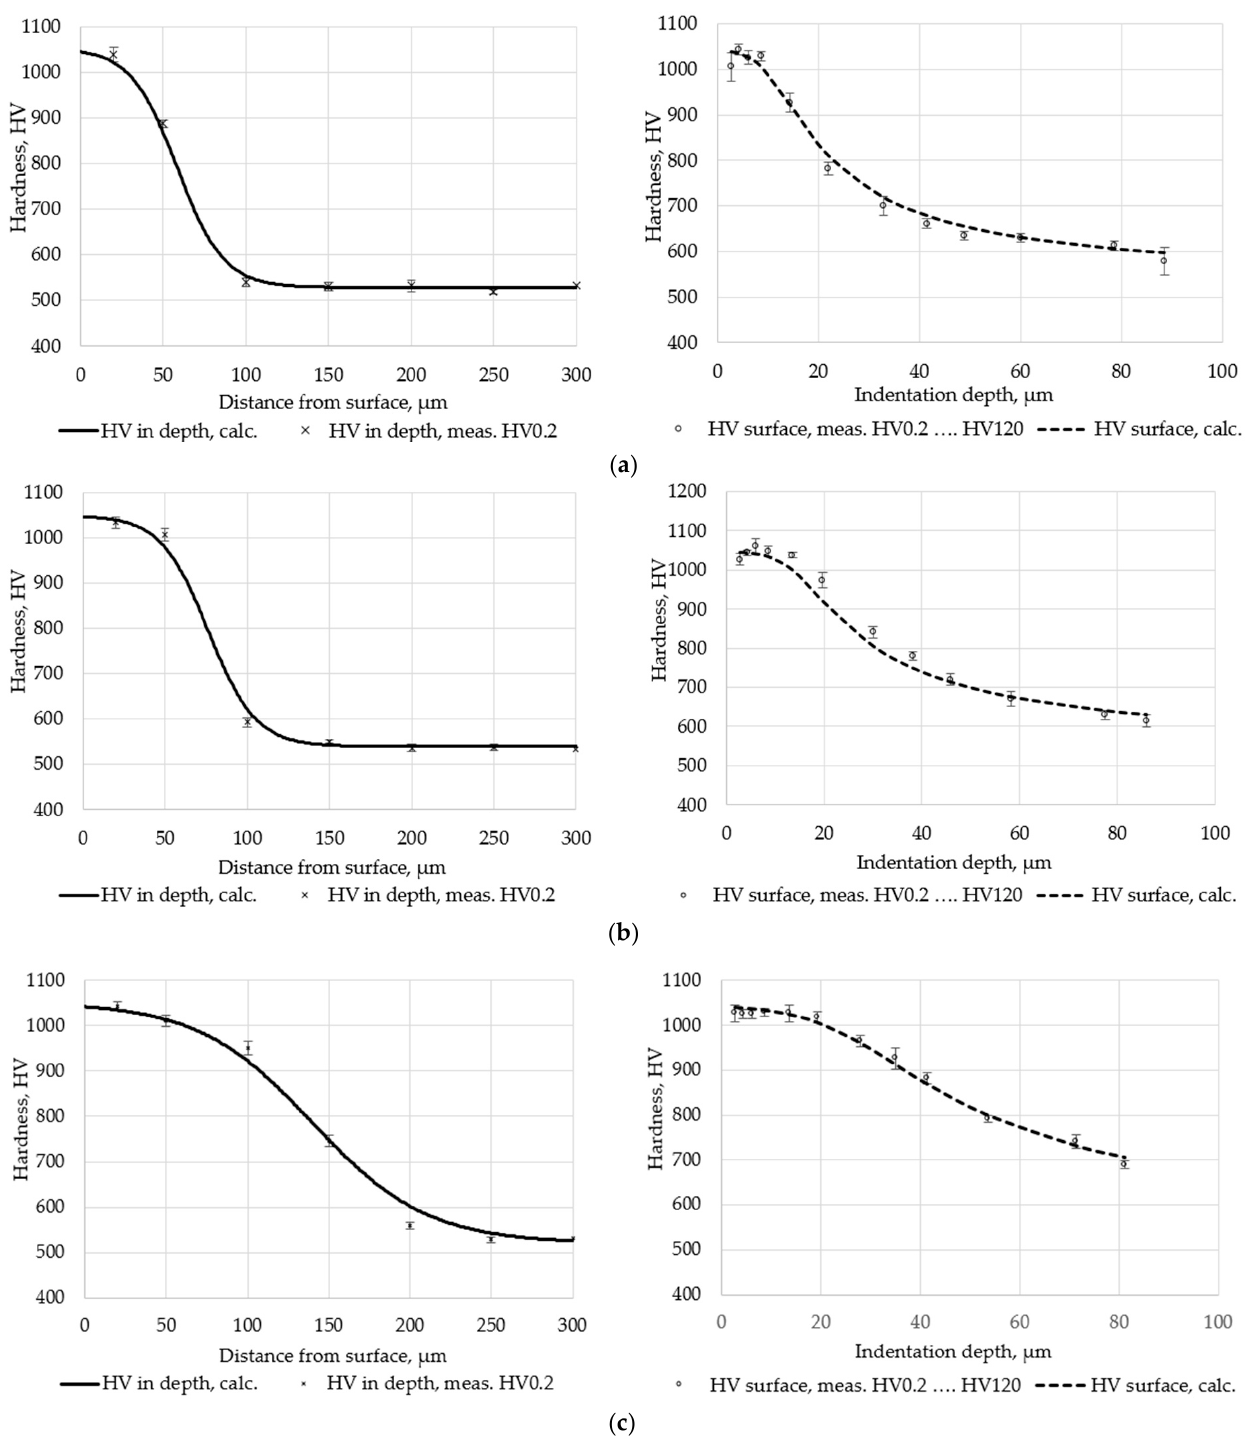
Figure 7. In-depth hardness ( left ) and surface hardness calculated from this ( right ): ( a ) 60 min nitrocarburizing; ( b ) 120 min nitrocarburizing; ( c ) 480 min nitrocarburizing. Table 5 The parameters of the sigmoid curve according to Equation (4) for different nitrocarburizing times.